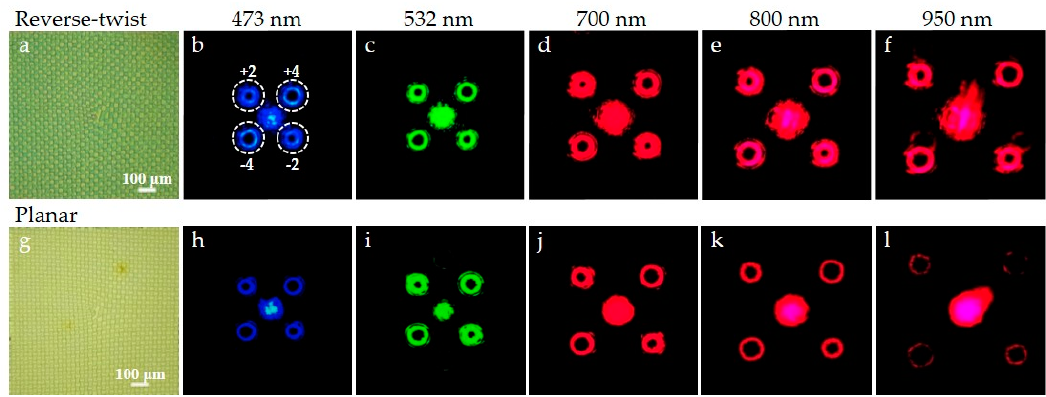
Figure 3. The micrographs of ( a ) double-layer reverse-twist and ( g ) planar 2 × 2 DVGs under crossed polarizers; ( b – f ) and ( h – l ) the corresponding diffraction patterns at 473, 532, 700, 800, and 950 nm, respectively.